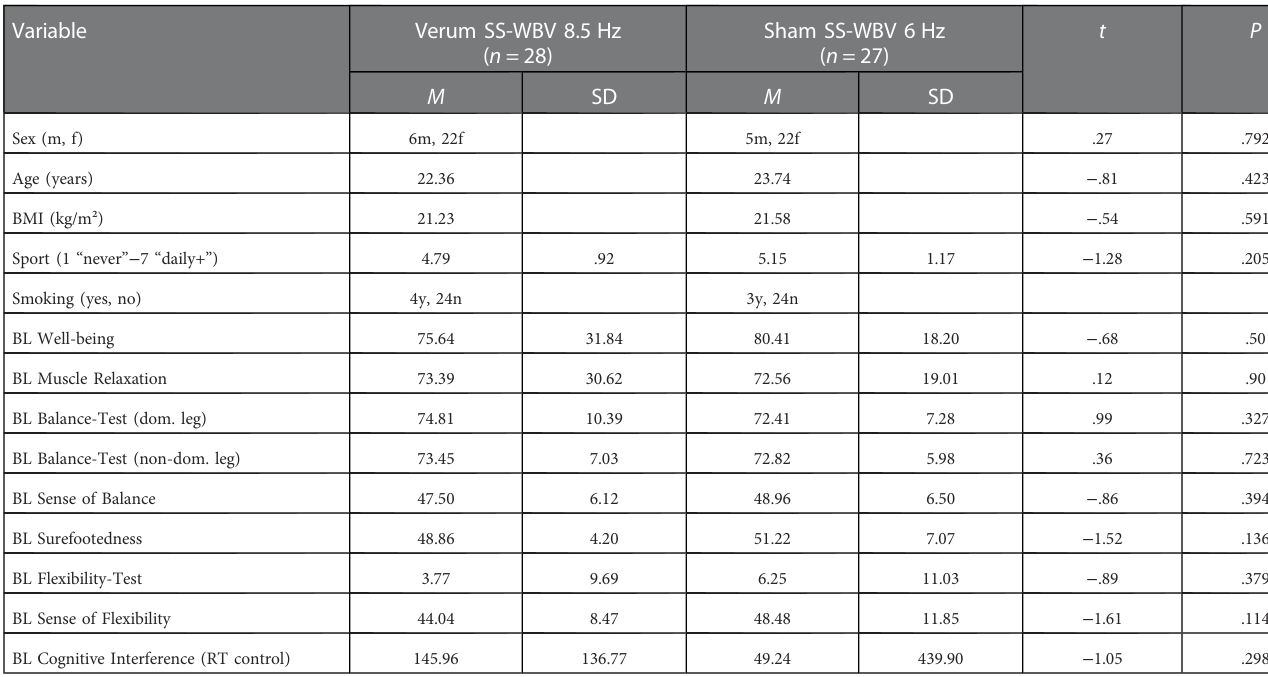
TABLE 1 Descriptive and inferential statistics.